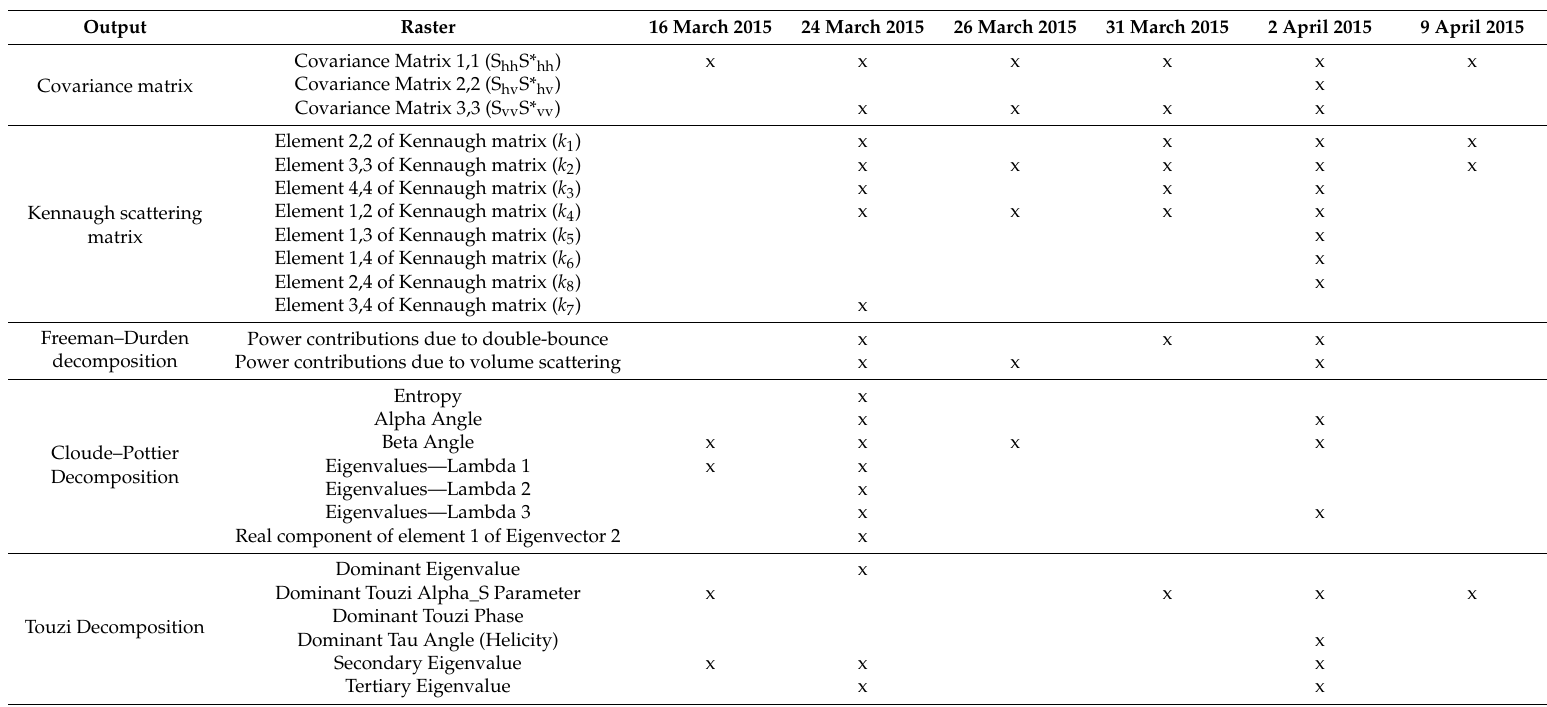
Table 3. Rasters included in the forested random forest model for each of the six image dates. Variables were selected using the varSelRF package in R. Only Radarsat-2 outputs included in at least one forest random forest model are listed. Data integration efforts that incorporated Worldview-3 and the enhanced topographic wetness index with Radarsat-2 used the Radarsat-2 9 April 2015 inputs, since the Worldview-3 image was collected on 6 April 2016. Output